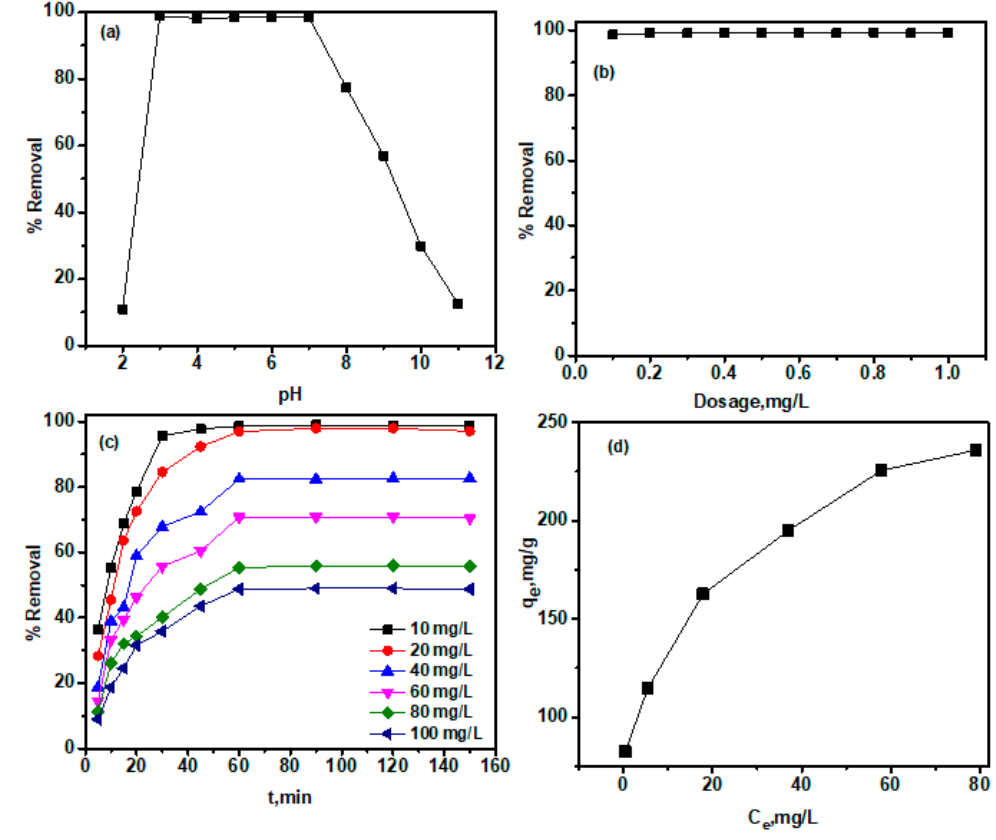
Figure 3. As(V) adsorption onto La 2 O 3 (10 – 100 mg/L, 0.1 g/L, pH 6.0) and the effects of ( a ) pH, ( b ) dosage (20 mg/L, pH 6.0) ( c ) kinetics, and ( d ) isotherms at 25 °C for 60 min equilibrium.